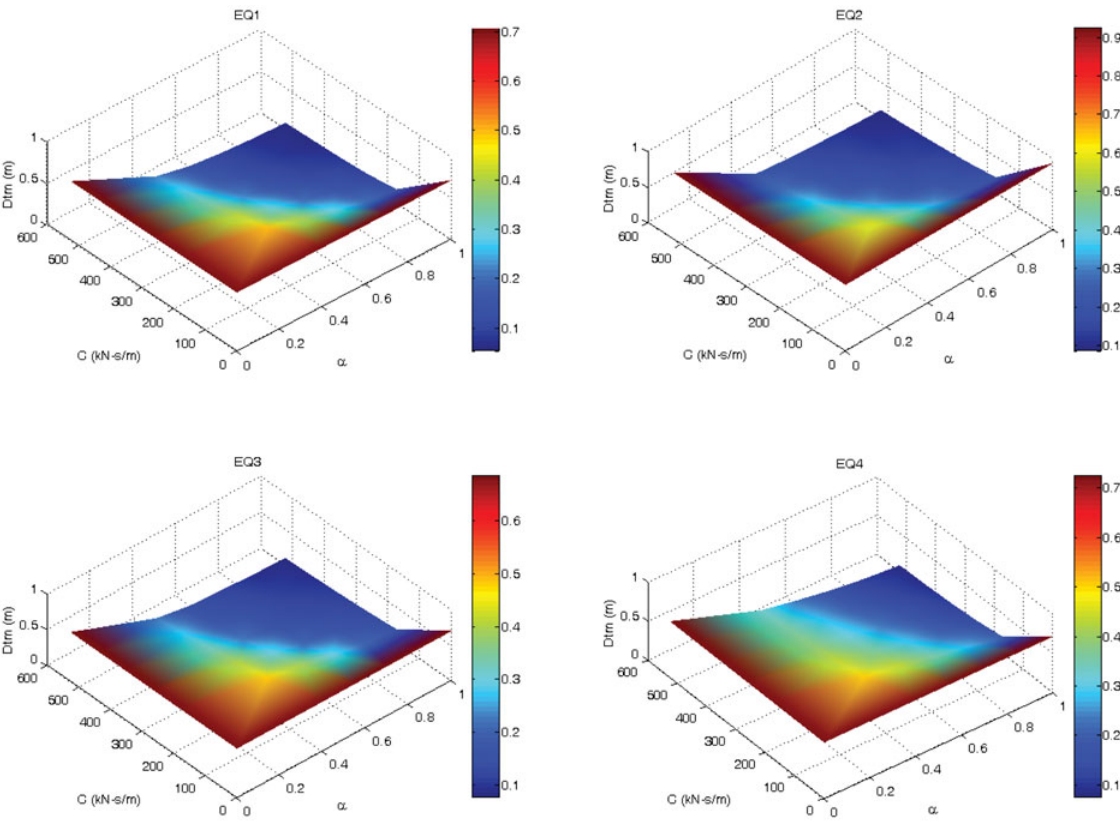
Fig. 4. Total maximum displacement ( D TM